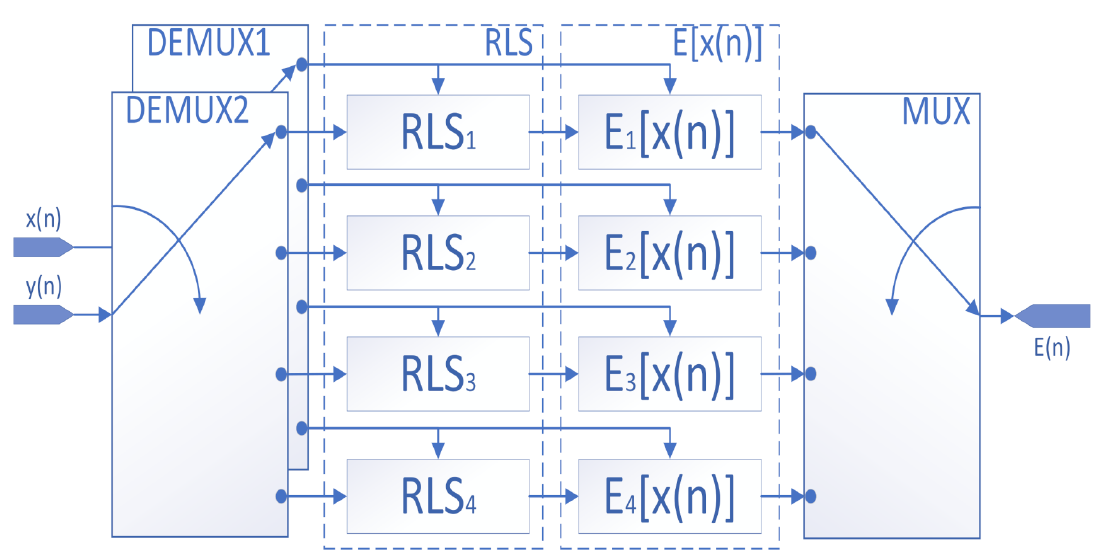
Figure 4. Concrete error estimation and reconstruction structure of the